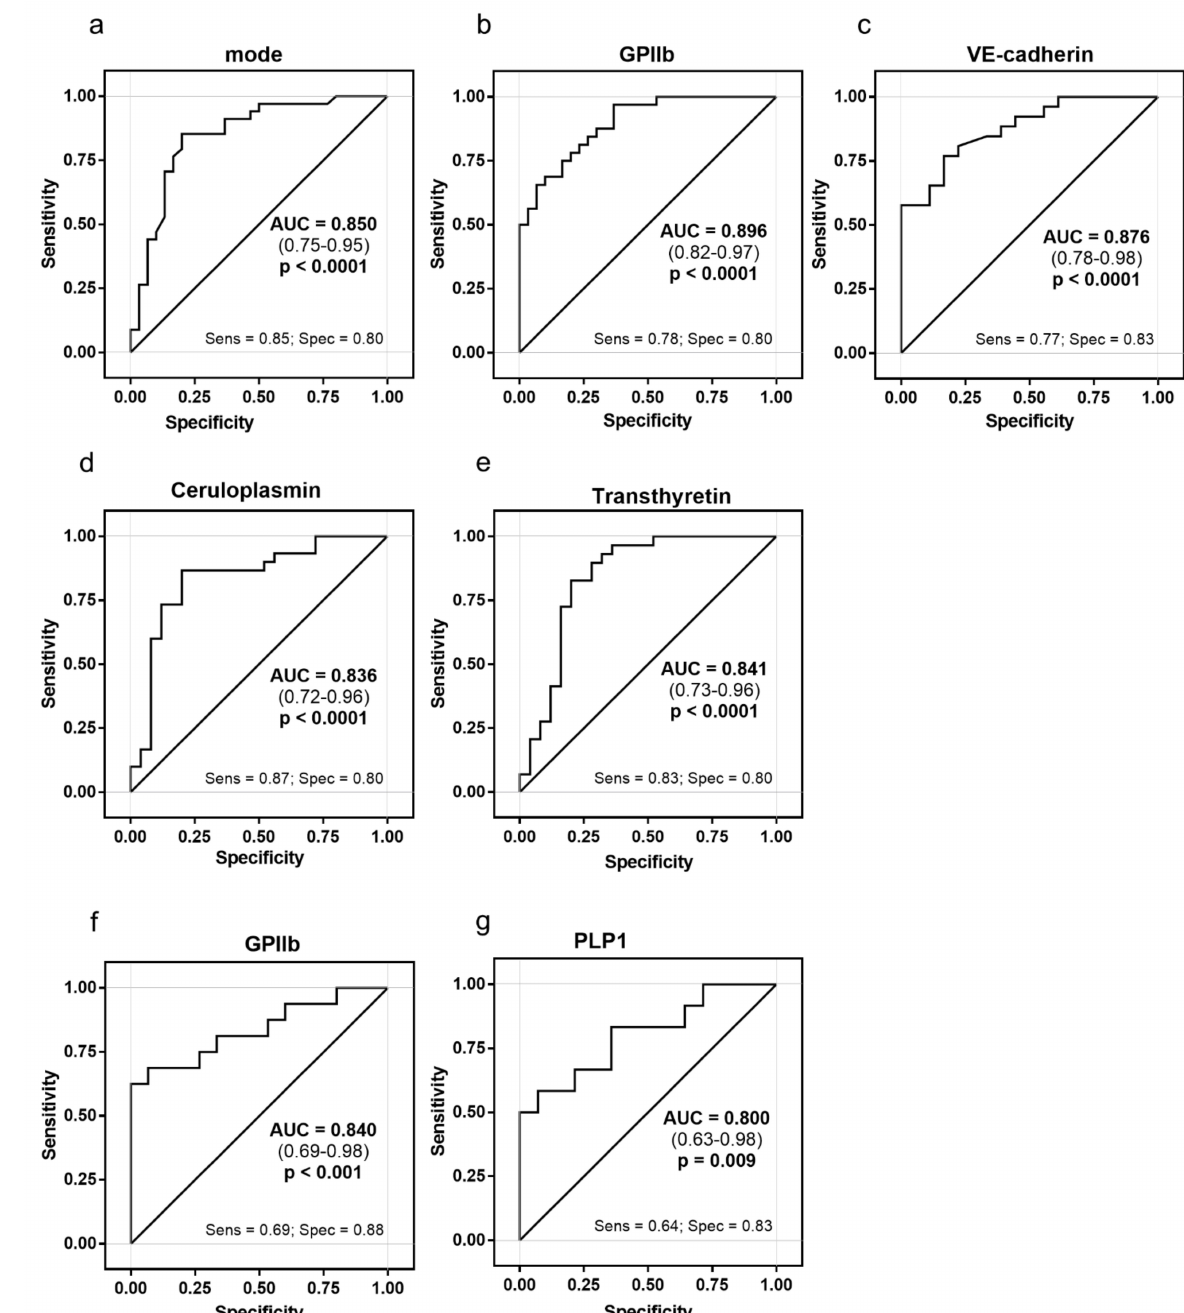
Figure 5. ROC curve analysis of exosomes versus cardiovascular clinical manifestation. Receiver operating characteristic (ROC) curve analysis was used to evaluate the ability of exosome to discriminate between STEMI (overall) and CCS patients ( a – e ) and between OHCA-STEMI and uncomplicated STEMI ( f , g ) in terms of dimension (mode) ( a ), GPIIb ( b – f ), VE-cadherin ( c ), ceruloplasmin ( d ), transthyretin ( e ) and/or PLP1 ( g ). Areas under the curve (AUCs), p values for AUC differences, cut-off values, sensitivity, and specificity are